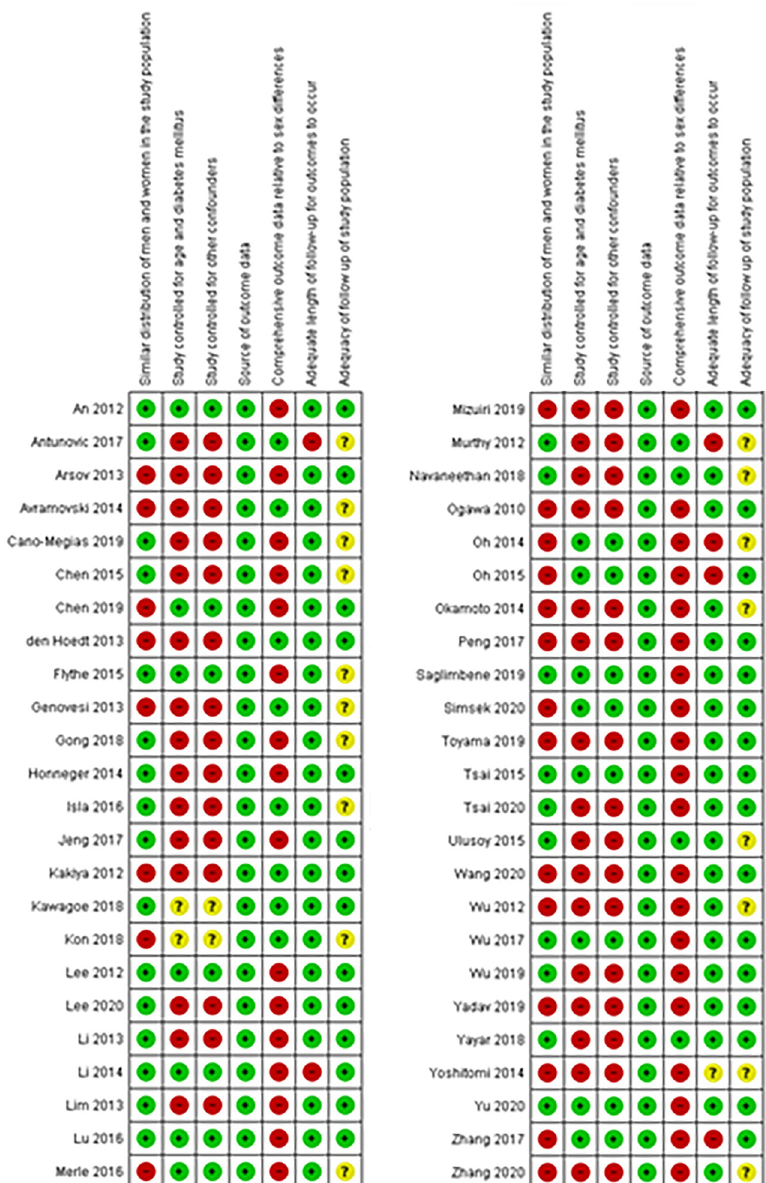
Fig 3. Risk of bias summary. Review authors’ judgements about each risk of bias item for each included